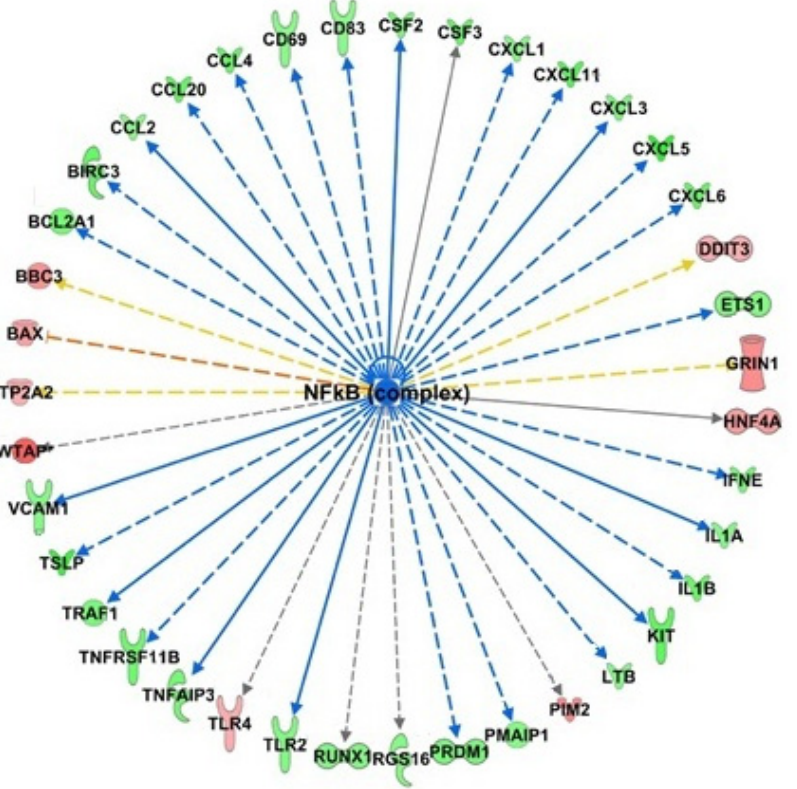
Figure 8. Identification of NF- κ B as an upstream regulator of transcriptional regulation by HT. Bioinformatics analysis with IPA software predicts the inhibition of NF- κ B as a regulator of down- regulated genes (depicted in green) and up ‐ regulated (depicted in red).